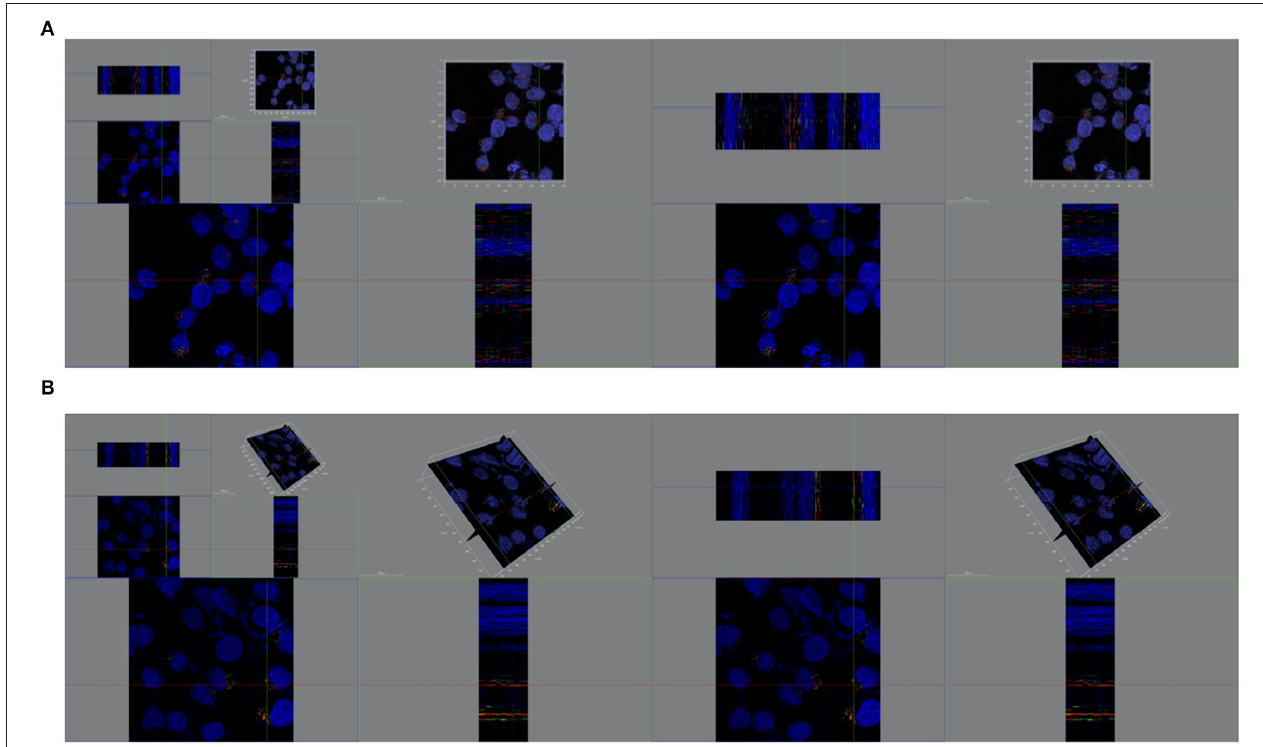
FIGURE 9 | Spatial distribution of cytosolic cisplatin with or without milk-exosomes delivery. (A) Spatial distribution of cis-FITC in A2780CP cells visualized from X axis, Y axis, Z axis with milk-exosome delivery. Red represents lysosomes, green represents cis-FITC, and blue represents DAPI stained nuclei. (B) Spatial distribution of cis-FITC in A2780CP cells visualized from X axis, Y axis, Z axis without milk-exosome delivery. Red represents endosomes, green represents cis-FITC, and blue represents DAPI stained nuclei.